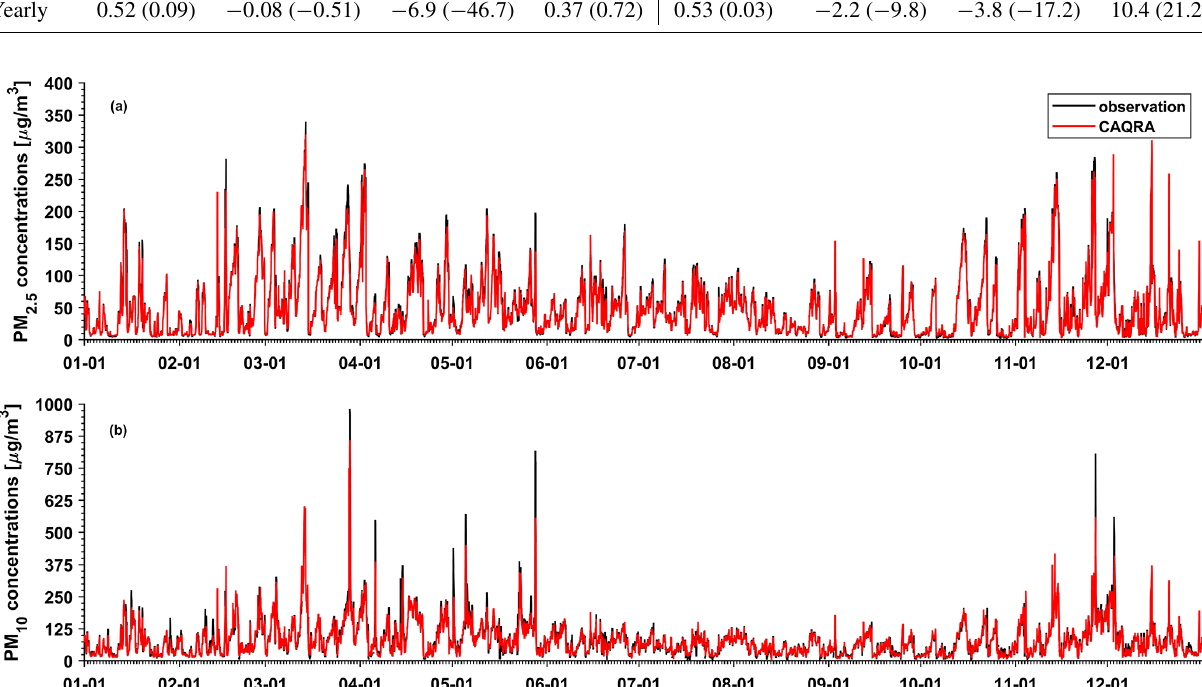
Figure 6. Time series of the site mean hourly (a) PM 2 . 5 and (b) PM 10 concentrations in Beijing obtained from the observations and CAQRA.